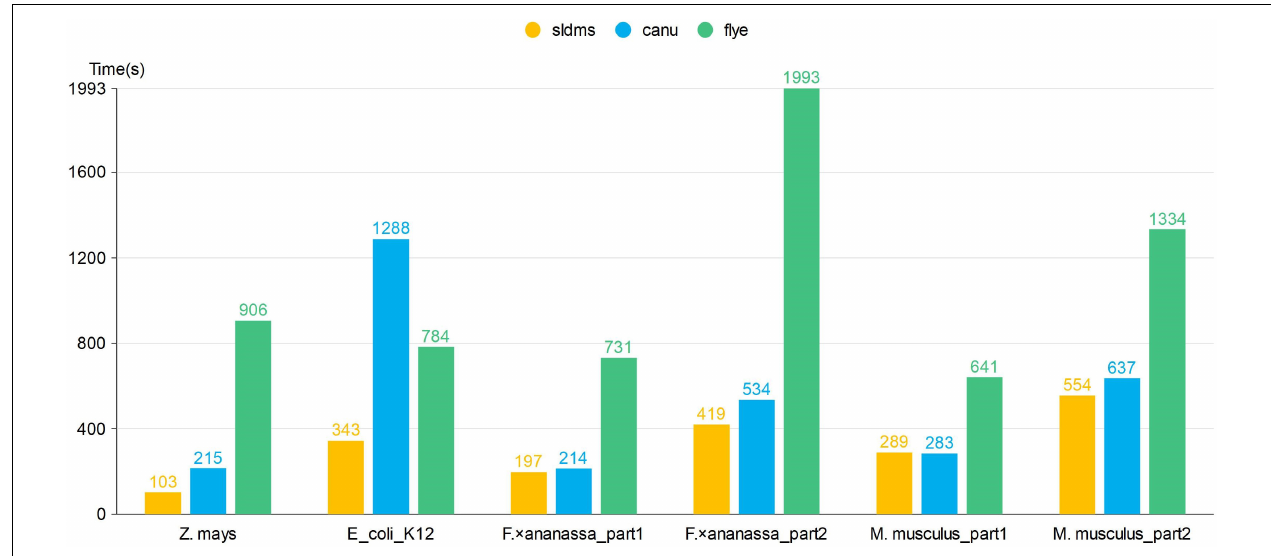
FIGURE 7 | Time required for different software programs to run PacBio-HiFi datasets to find the overlapping regions.